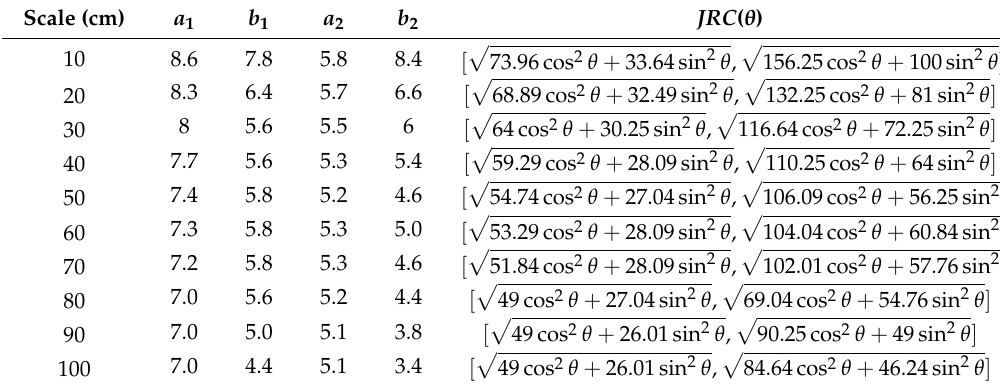
Table 1. NN functions of JRC ( θ ) for the JRC expressions of different sized joint samples and I (cid:15) [0, 0.5]. Scale (cm)